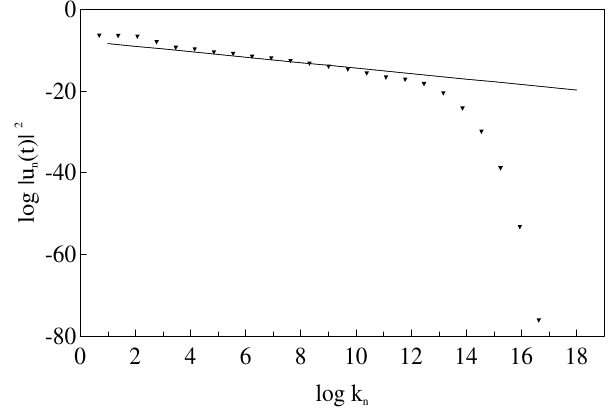
Figure 87: We show the kinetic energy spectrum | 𝑢 𝑛 ( 𝑡 ) | 2 as a function of log model. The full line refer to the Kolmogorov spectrum 𝑘 − 2 / 3 𝑛